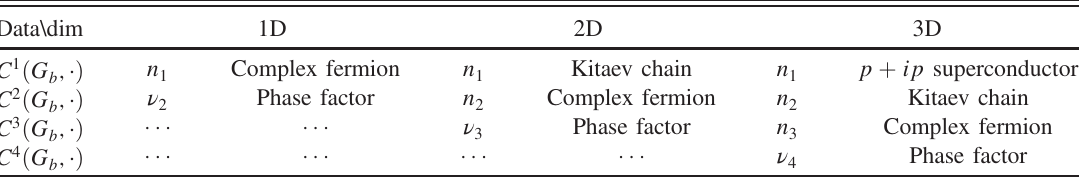
TABLE I. Layers of classification data. The cochains n C d − 2 ð G ; Z describe the decorations of 0D complex fermions, 1D Kitaev chains, and 2D p þ ip superconductors b T Þ (SCs) in the d -spatial dimension model, respectively. And ν in the wave function, which is related to the group cohomology classification of BSPT phases in d -spatial dimension. There is also n 0 data in each dimension, if we want to classify fermionic invertible topological orders. We omit these n 0 states in this paper, for they do not need any G trivialization group which will be discussed below.